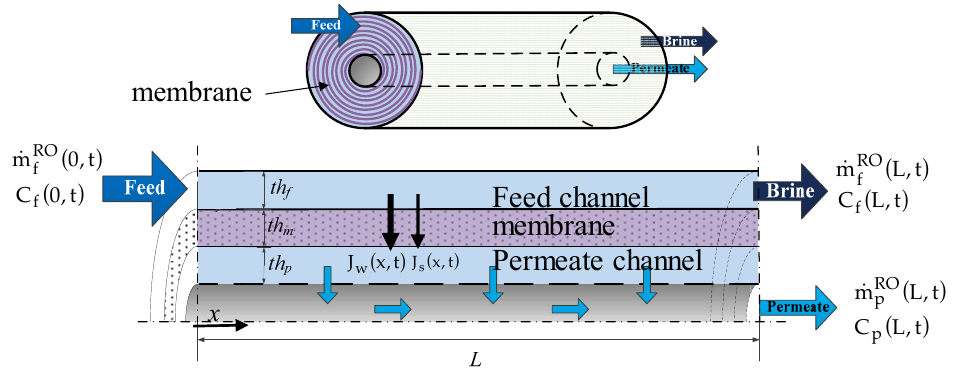
Figure 8. Schematic of the reverse osmosis (RO) membrane modeling.